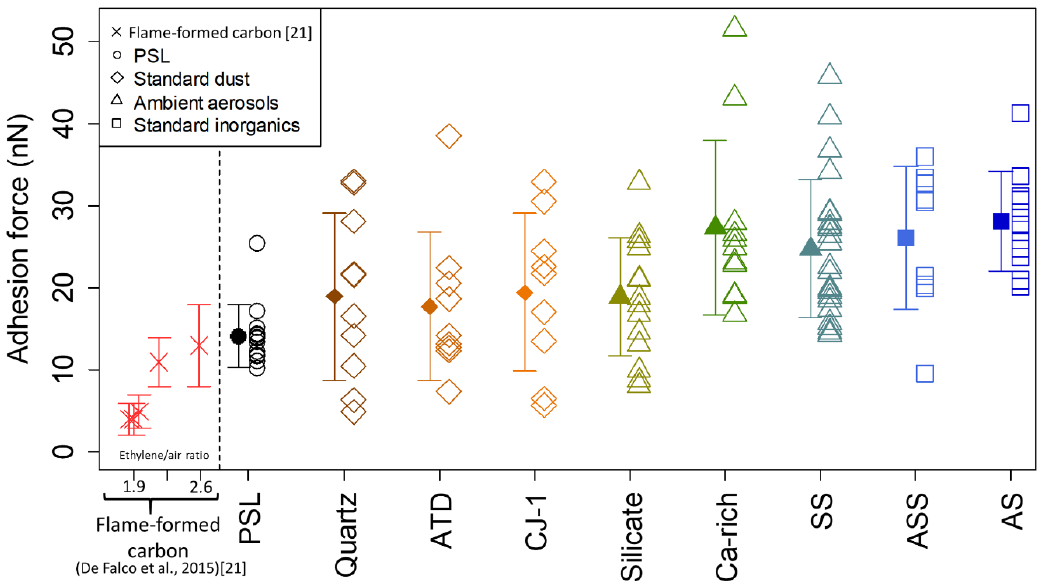
Figure 6. Comparison of adhesion force of aerosol particles measured in this study. A range of adhesion force values for flame-formed carbon soot particles [21] are also shown for comparison. Hollow shapes indicate the adhesion force values of individual particles, whereas solid shapes and whiskers indicate the mean and standard deviation, respectively.